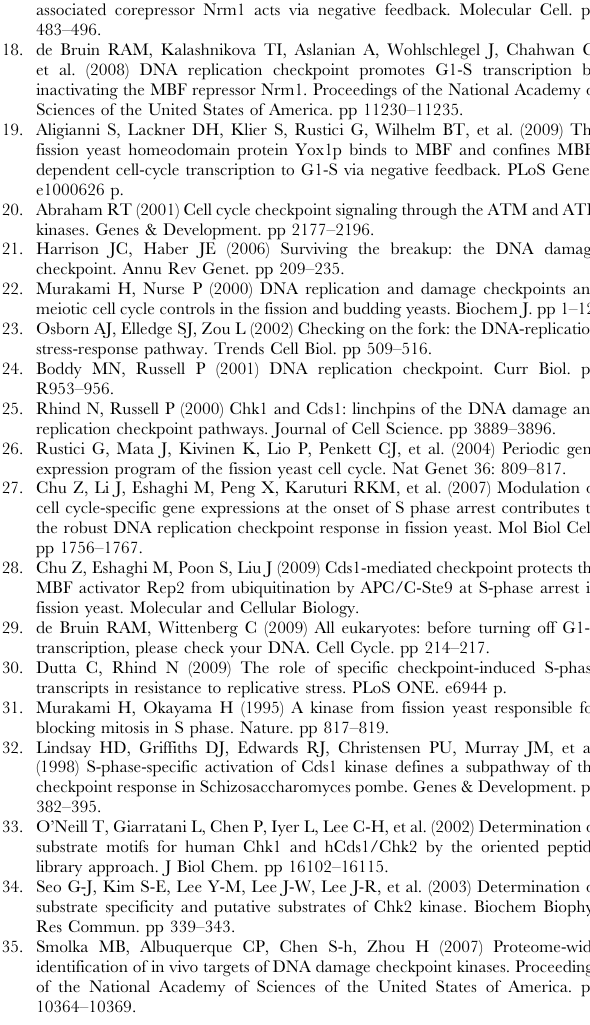
Figure S2 Biological repeat experiment of Figure 3A. See Figure 3A legend for experimental